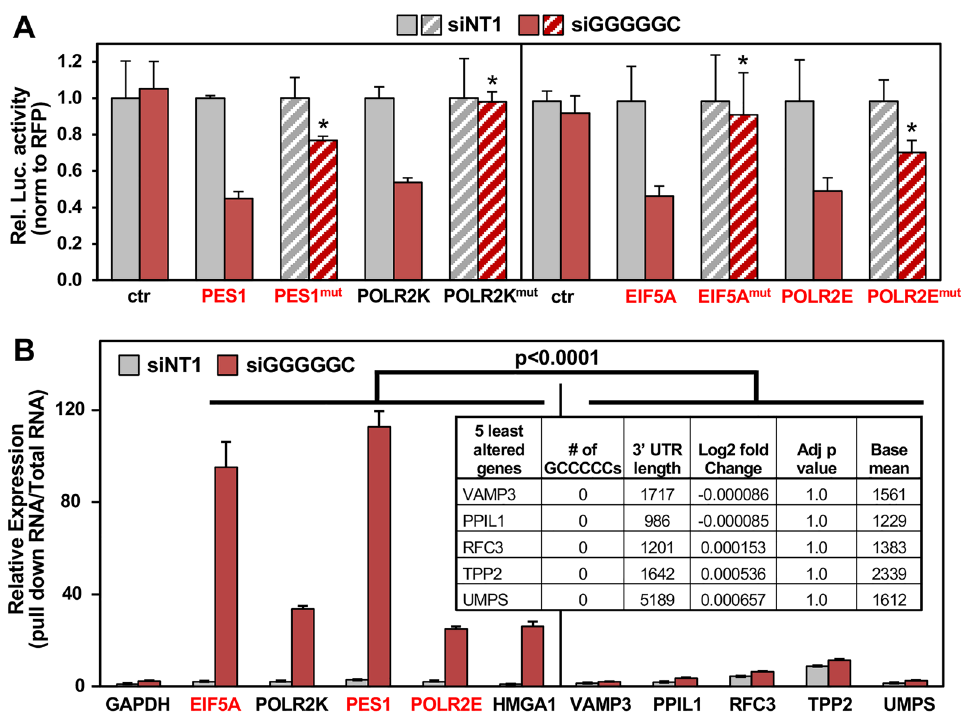
Figure 5. Validation of GCC CCC seed matches located in the 3 ′ UTR of abundant genes being targeted by siGGG GGC . ( A ) Relative luciferase activity of control plasmid (pmiR-Target), wild-type and mutant 3 ′ UTR constructs of 4 of the genes in Fig. 4B in 293T cells. Data are shown as mean ± SD of three replicates. p-values (Student’s t test, *p < 0.05) represent comparison between change in relative luciferase of cells co-transfected with wt/mutant constructs (50 ng) and siGGG GGC (20 nM) normalized to cells transfected with siNT1. ( B ) Enrichment of siGGG GGC target mRNAs in biotin-streptavidin pulled down RNA normalized to input RNA in HeyA8 cells transfected with 50 nM Bi-siNT1 or Bi-siGGG GGC for 20 h by real-time PCR. Inset: Table showing 5 selected control genes (> 1000 normReads) expression of which did not change in RNA-seq data derived from HeyA8 cells transfected with 10 nM siGGG GGC vs. siNT1 for 24 h. Each bar represents ± SD of three replicates. Student’s t test was used to calculate p-value. Survival genes are shown in